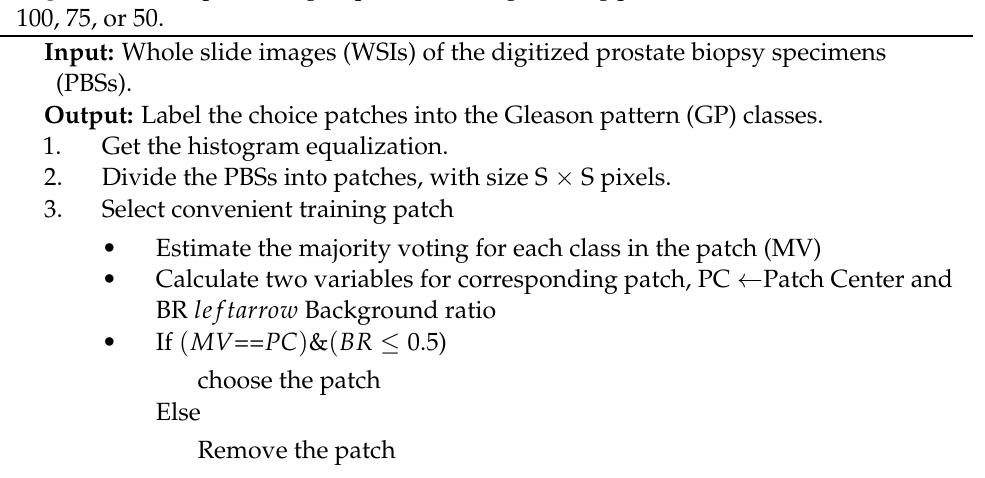
Algorithm 1: Preprocessing step and selecting training patches, the value of S is 100, 75, or 50.